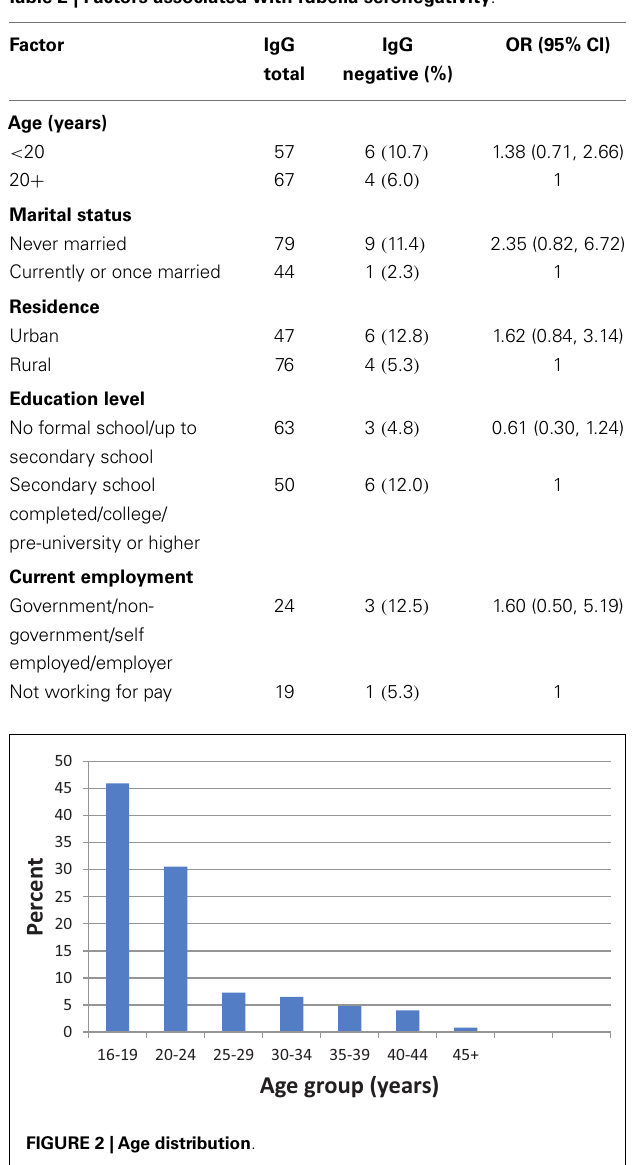
FIGURE 2 |Age distribution